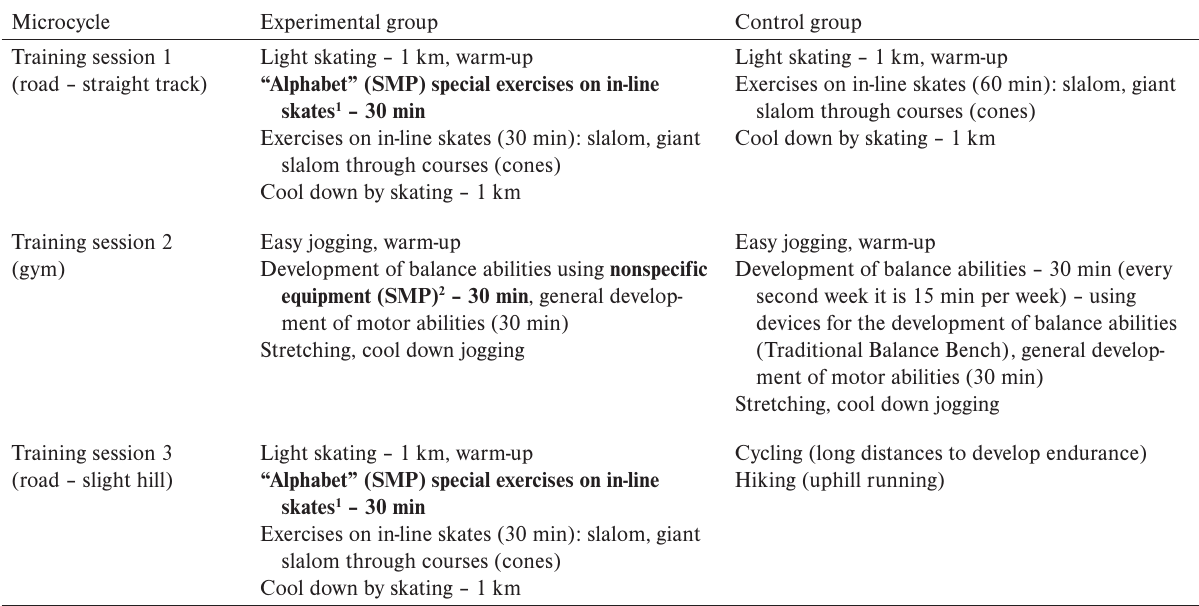
Training session content in experimental and control group in microcycle